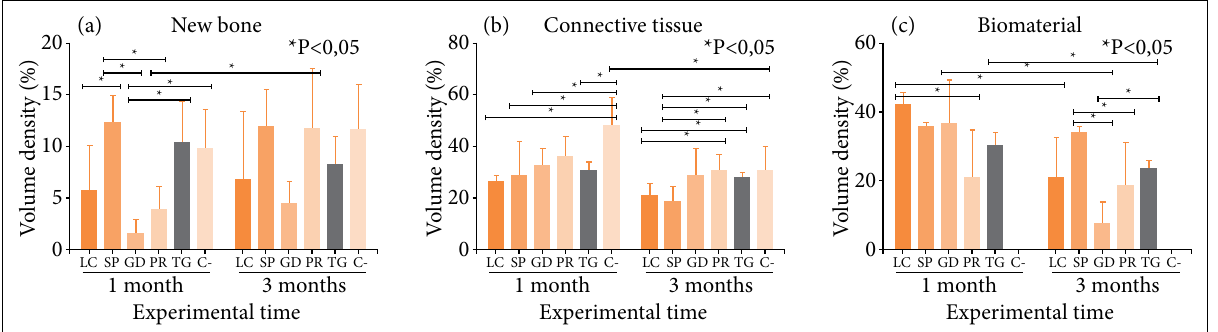
Figure 3 – Histomorphometric analysis of volume density of (a) new bone, (b) connective tissue, and (c) biomaterial in critical size bone defects in rat calvaria for the different experimental groups at one and three months. Percentage data of control (C-), LuminaCoat (LC), Surgitime PTFE (SP), GenDerm (GD), Pratix (PR) and TechGraft